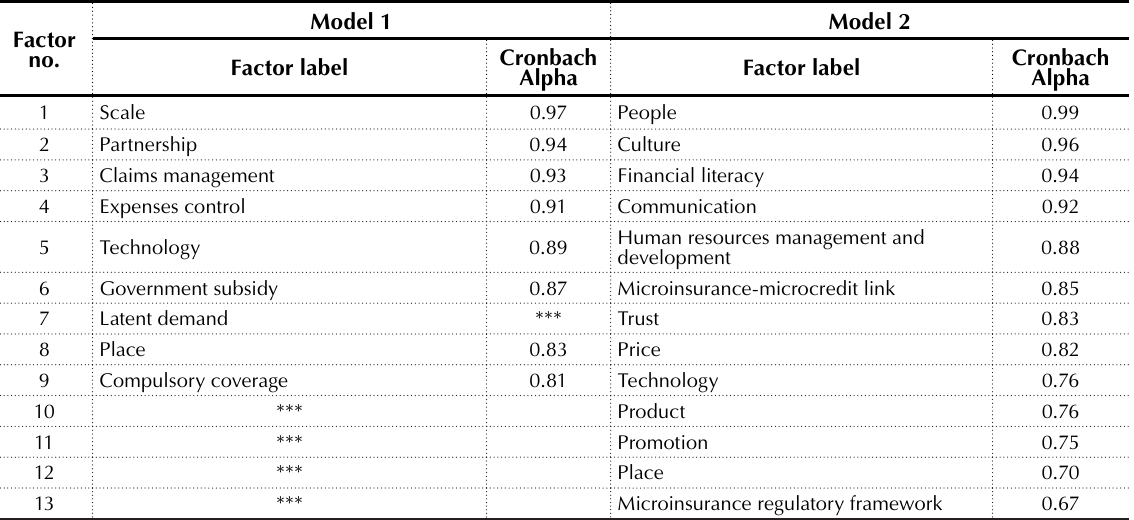
Table 4. Reliability of the factors in the two models Factor no.